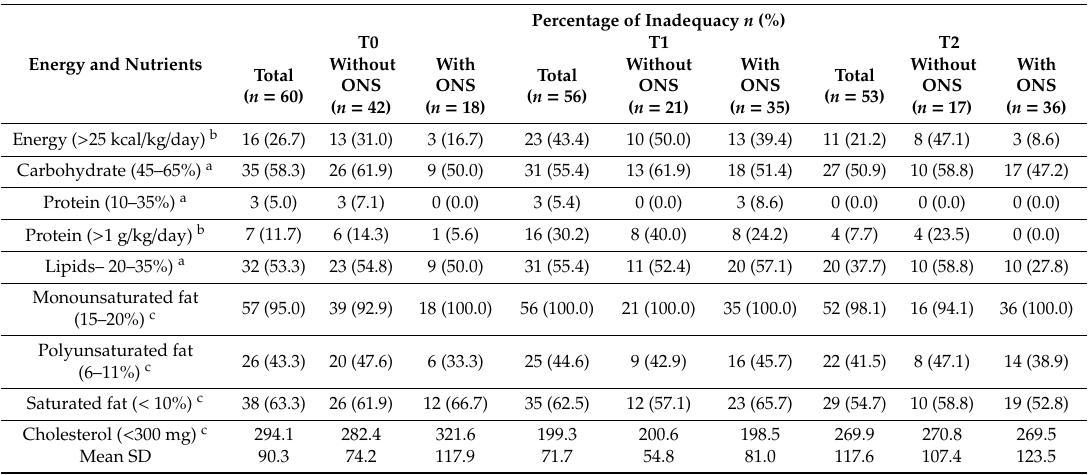
Table 3. Percentage of macronutrient inadequacy, protein in g / kg / day, energy in kcal / kg / day, and mean values and standard deviation of cholesterol intake in head and neck cancer patients during (chemo)